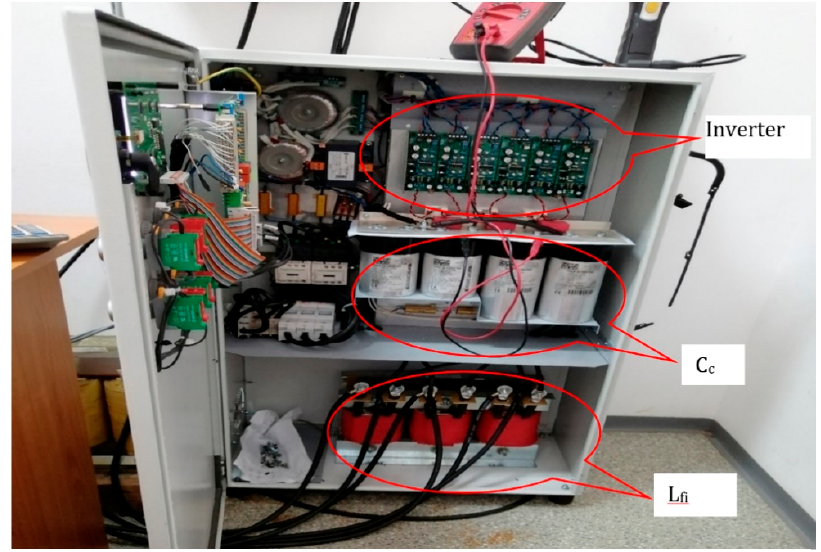
Figure 9. Picture of the shunt active power filter.